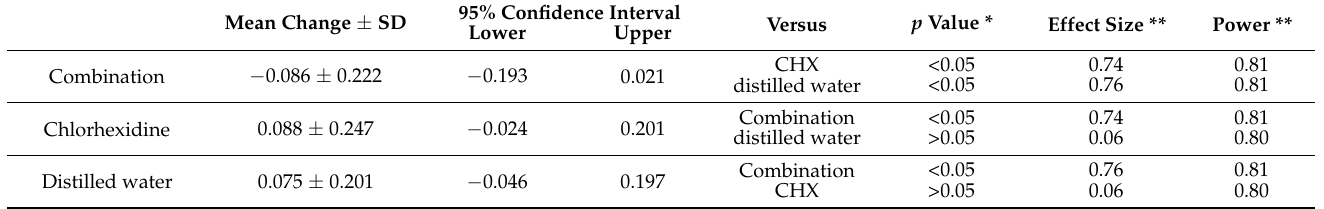
Table 2. GCF influx changes (influx after–influx before) after rinsing with different study interventions. Mean Change ± SD